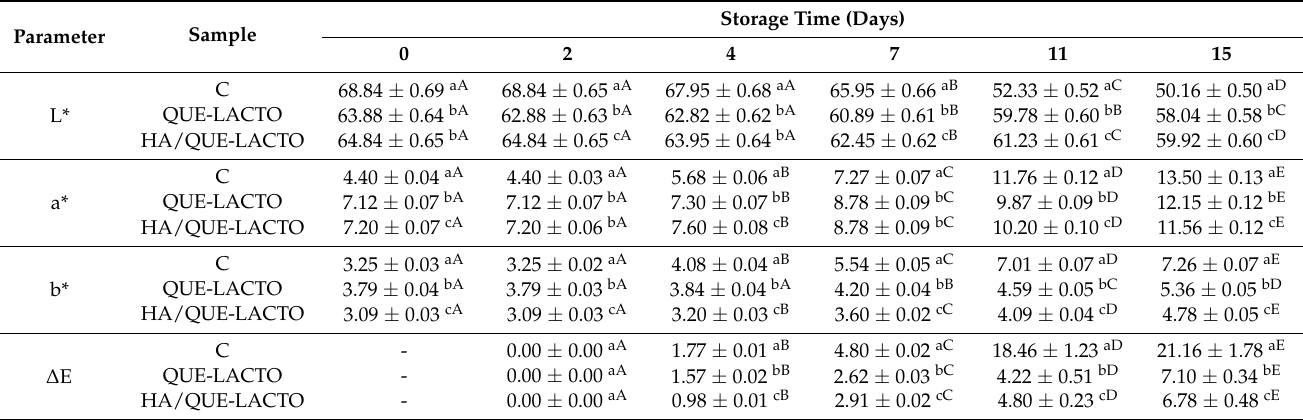
Table 2. Effects of alginate-based coatings on the colour of pork meat samples during the cold